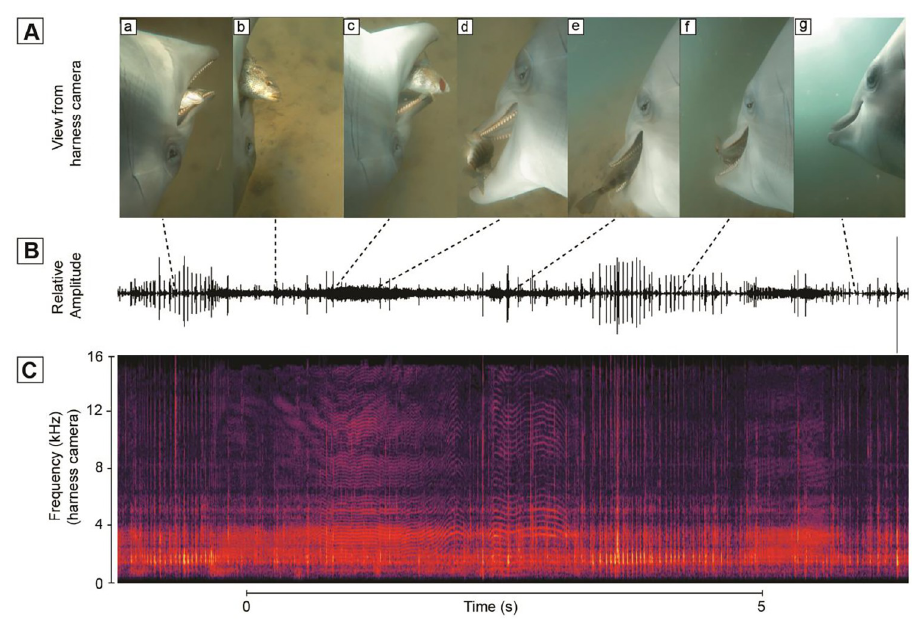
Fig 2. Fish capture sequence. A . View of dolphin fore body while capturing fish. A. the dolphin contacts the fish, b. the fish flees as the eye focuses on the fish, c. the fish escapes, d. is found again. E. and is swallowed B. Relative amplitude of sound recorded as dolphin S located, chased and captured wild fish. C . Spectrogram of audible sound showing variations in pulse rate and peak frequency characteristic of a